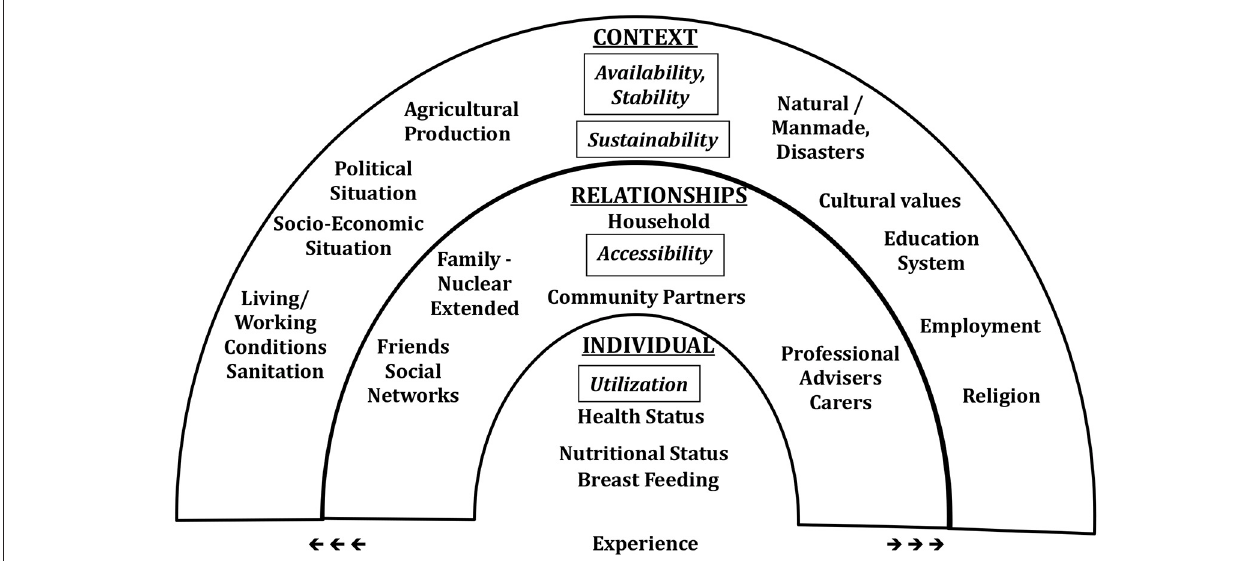
FIGURE 1 | Sociotype ecological framework of some of the elements of the sociotype in relation to the stresses of, and coping strategies for, food insecurity. Italics show the dimensions of food security and